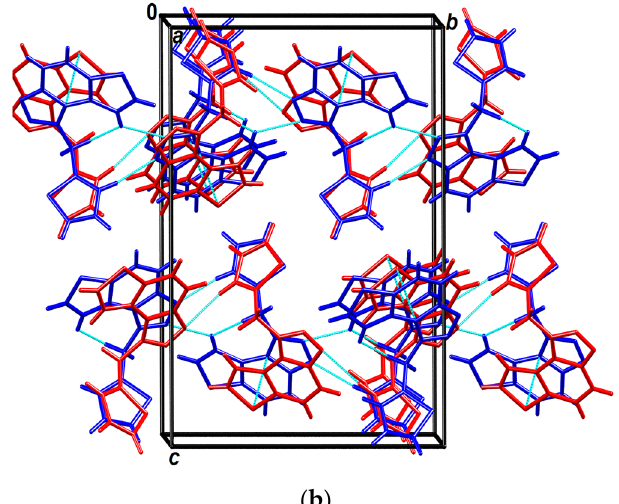
Figure 8. ( a ) Overlay of molecules A (red) and B (blue); ( b ) Crystal packing viewed approximately in the direction of the axis a . Molecules A are red, B are blue, and short intermolecular contacts (weak hydrogen bonds and π -stacking) are shown as cyan-do tt ed lines.